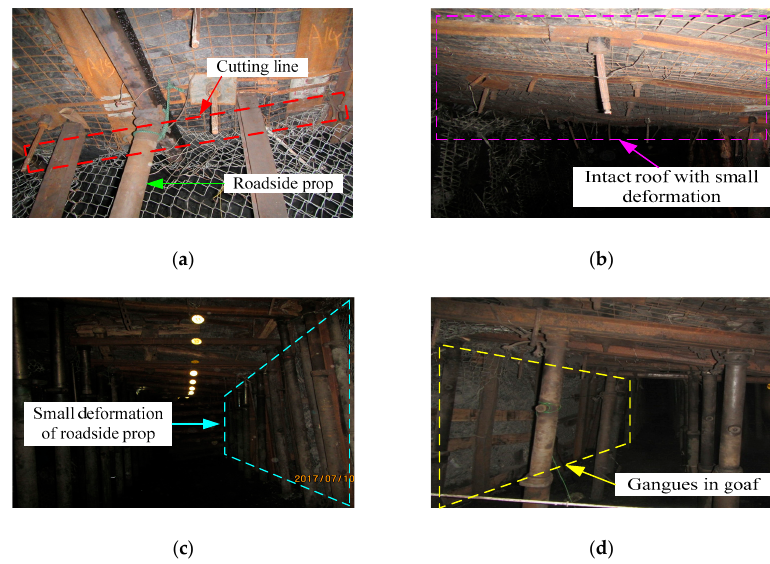
Figure 19. Effects of the surrounding rock control in No. 2415 headentry. ( a ) Cutting line at gob-side; ( b ) Roof deformation; ( c ) Roadside prop deformation; ( d ) Gangues retaining along gob-side.